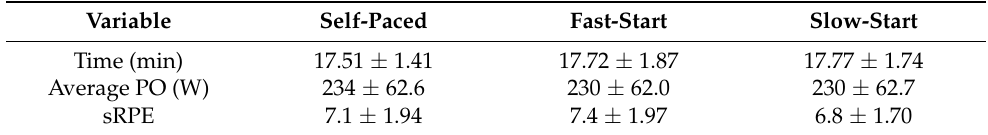
The pattern of PO, RPE, blood lactate concentration, and HR within the three TTs is shown in Figure 1.